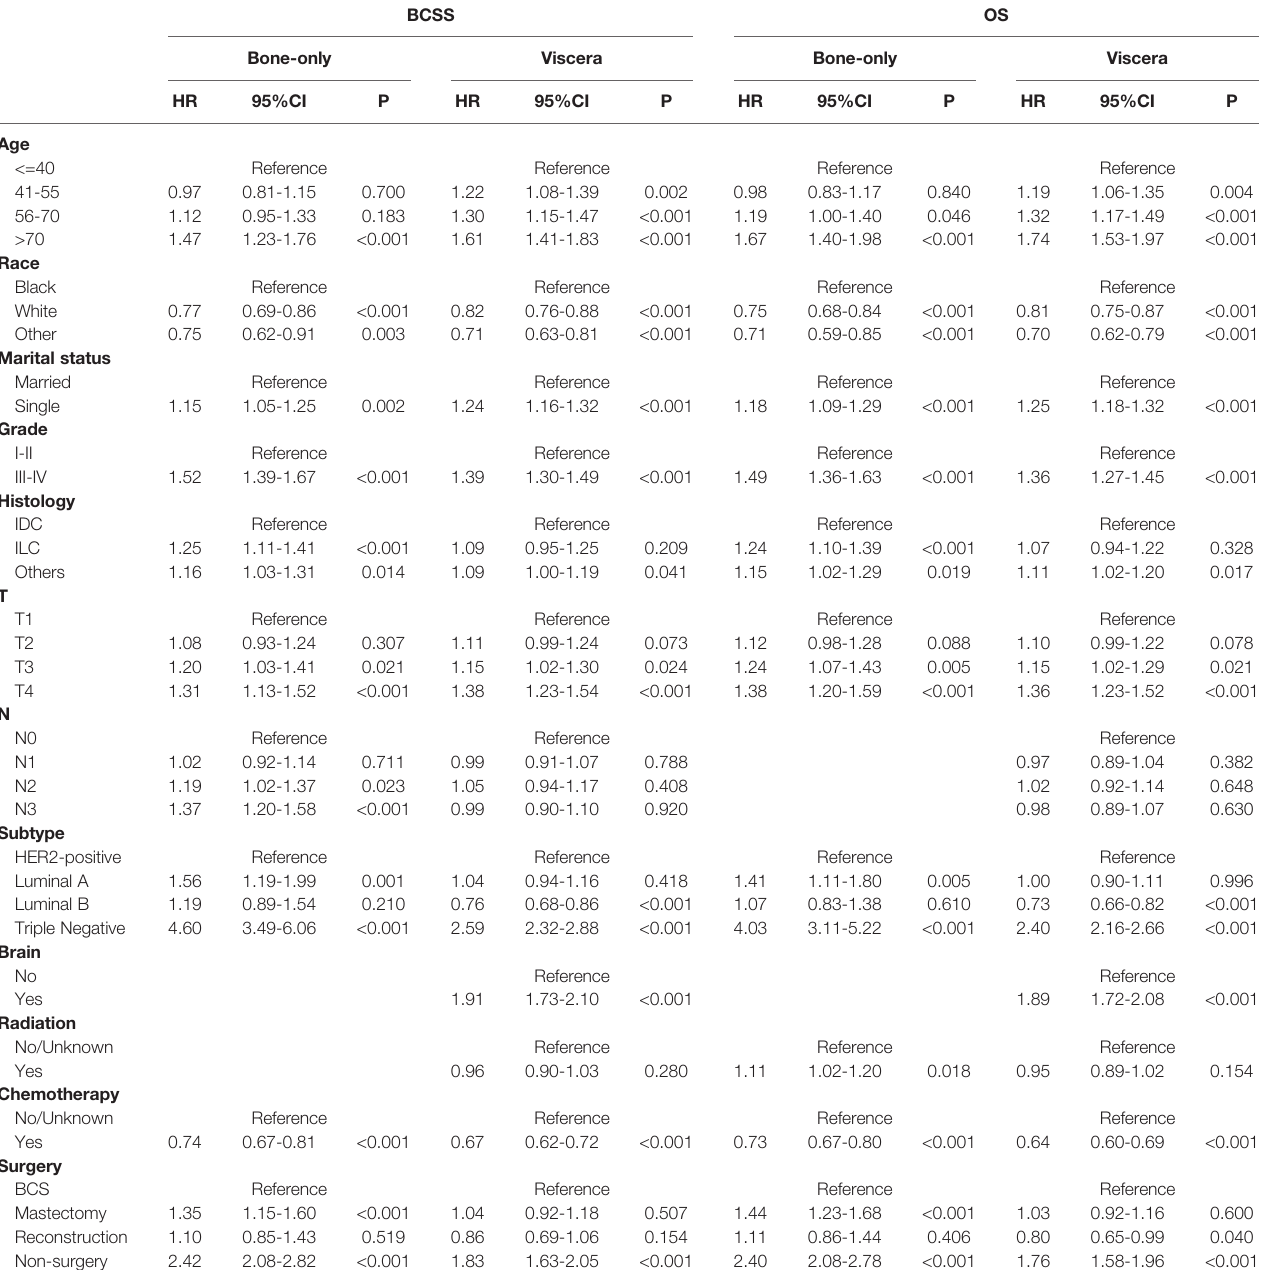
TABLE 4 | Multivariate analysis for independent predictive factors of different metastatic patterns. BCSS OS Bone-only Viscera Bone-only